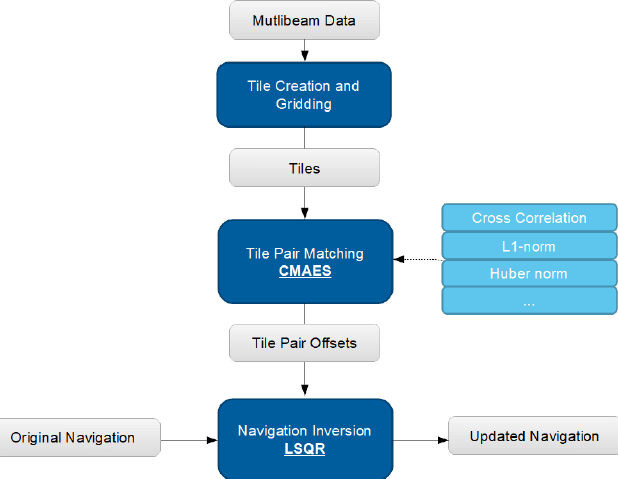
Figure 1. Overview of the Tile matching process. Data objects are shown in